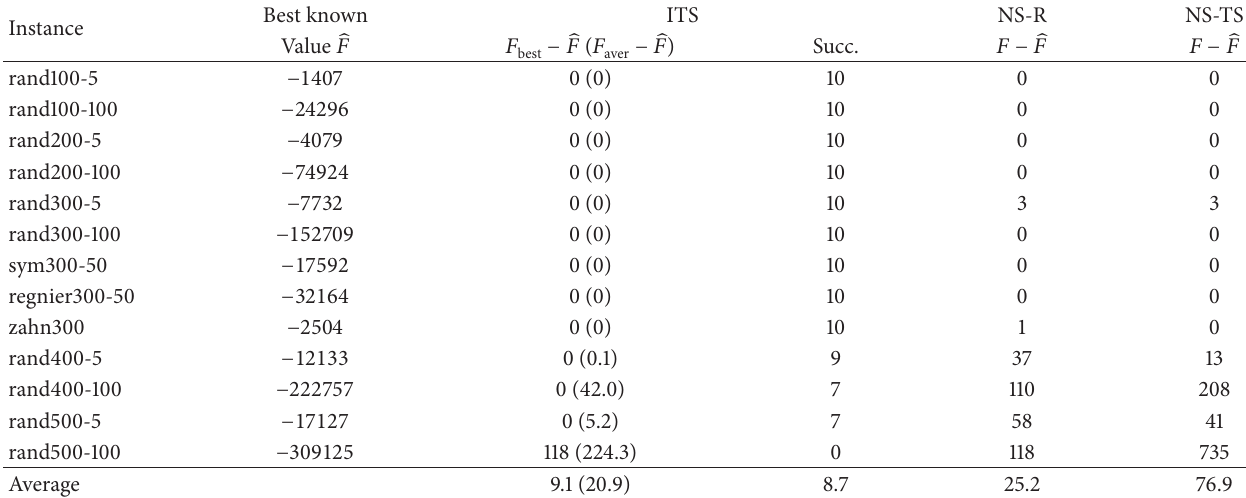
Table 1: Comparison of ITS with NS-R and NS-TS on the CPP instances considered by Brusco and